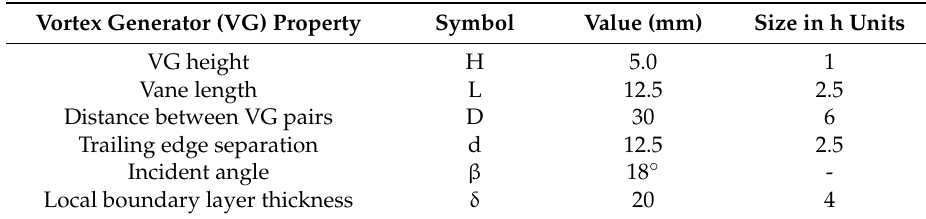
Table 1. Vortex generator geometry in the Advanced Aerodynamic Tools of Large Rotors (AVATAR) project.